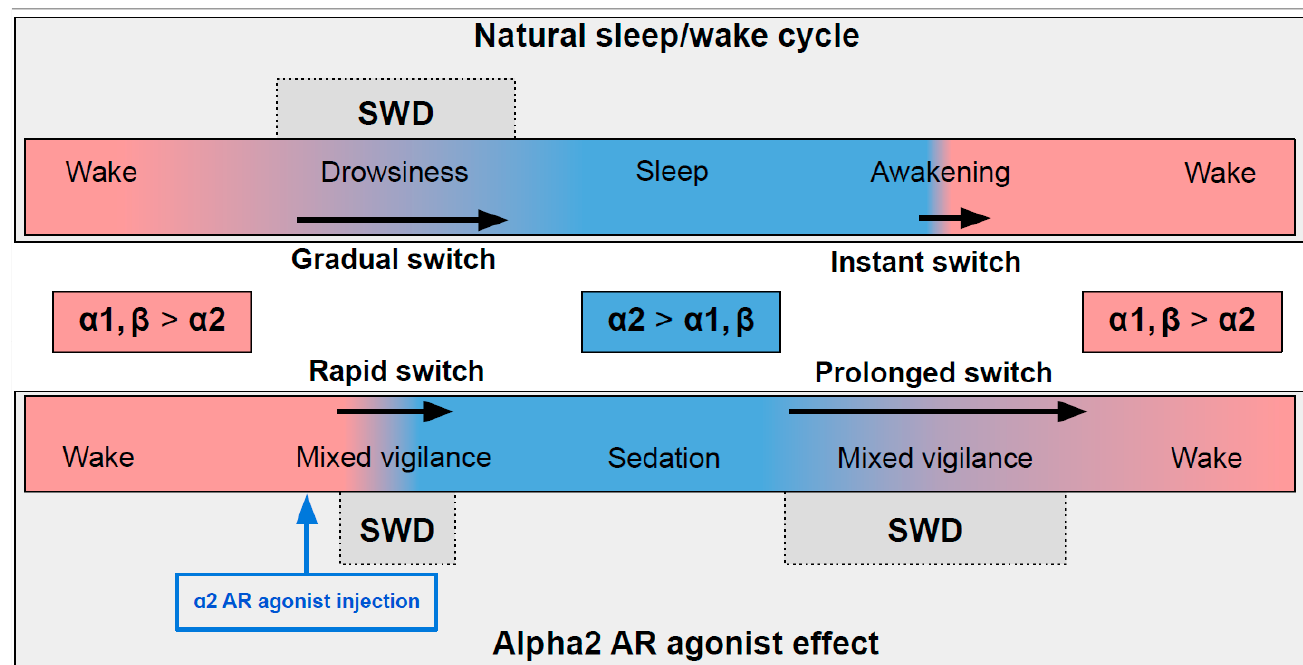
Figure 2. The schema demonstrating adrenergic mechanisms of sleep modulation and spike-wave discharge (SWD) modulation. The upper plot demonstrates the natural drug-free state. The bottom plot—pharmacologically induced condition after administration of agonist of alpha2 adrenore- ceptors. Noradrenaline affects alpha1, alpha2 and beta-receptors, and NA concentration during sleep/sedation is lower (blue area) than during wakefulness (rose area). Transient states between wake and sleep/sedation are favorable for SWD to occur. See explanations in the text.